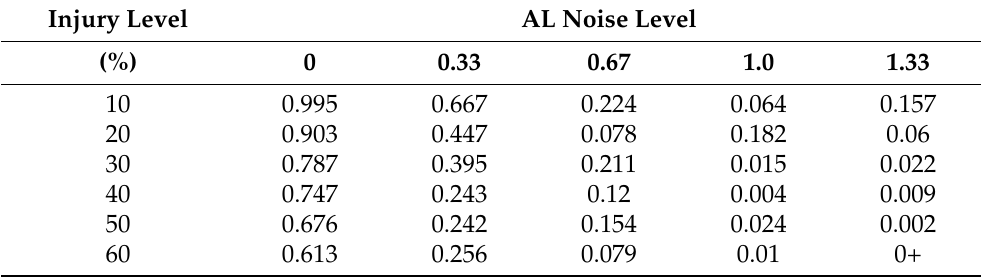
Table A5. P -values for comparison of AL noise’s effects on top-scoring responses vs. average responses, post-injury (see Figure 7A vs. C). “0+” indicates p -value < 0.0005. N = 98 to 112 (mean = 106).